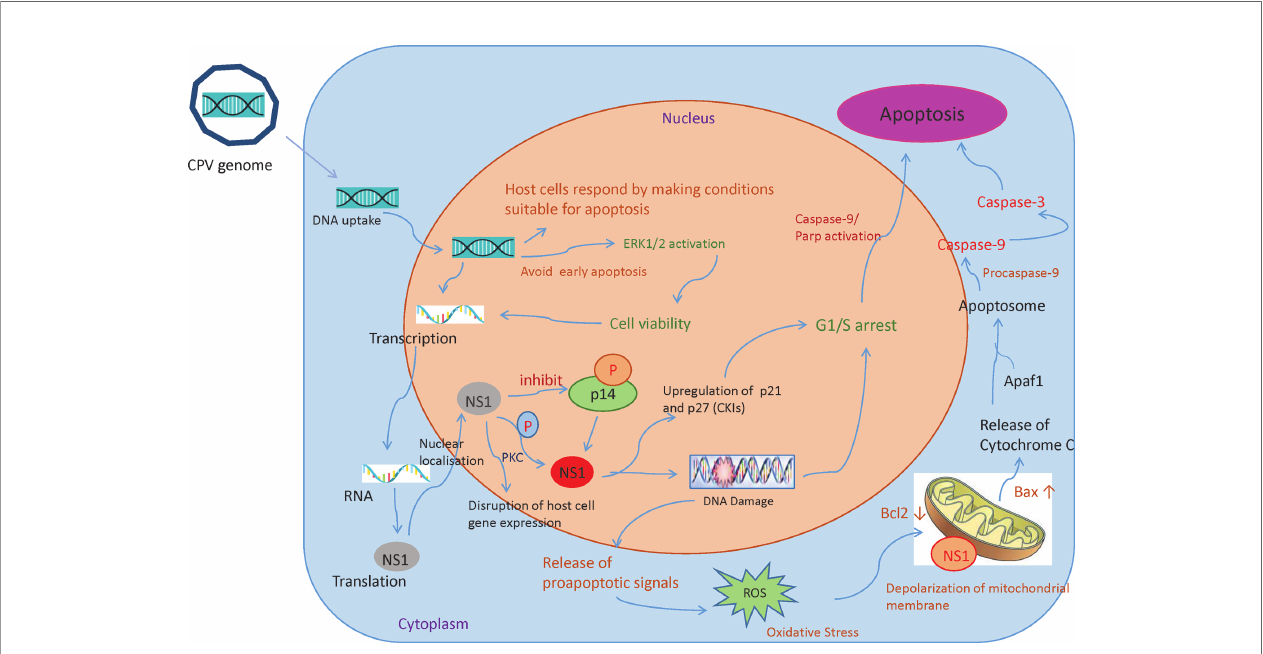
FIGURE 4 | Mechanisms involved in CPV and NS1 mediated cancer cell death: Once the CPV genome is sensed by the host cells, they respond by activating caspase 9 and depolarizing the mitochondrial membrane. This causes the cells to undergo apoptosis. However, CPV activates cell survival pathways (ERK1/2) thereby mediating viral gene expression. CPV2.NS1 expression causes inhibition of host cell DNA replication. After activation by phosphorylation, NS1 causes DNA damage leading to cell cycle arrest at the G1/S phase before causing apoptosis. NS1 also associates with outer mitochondrial membrane and DNA damage response leads to activation of pro-apoptotic signals (Bcl2 and Bax) thereby creating oxidative stress. This cellular stress causes a decrease in mitochondrial membrane permeability, the release of Cytochrome C which further forms apoptosome complex with Apaf1, activating caspase 9, fi nally inducing cell death by intrinsic/mitochondrial